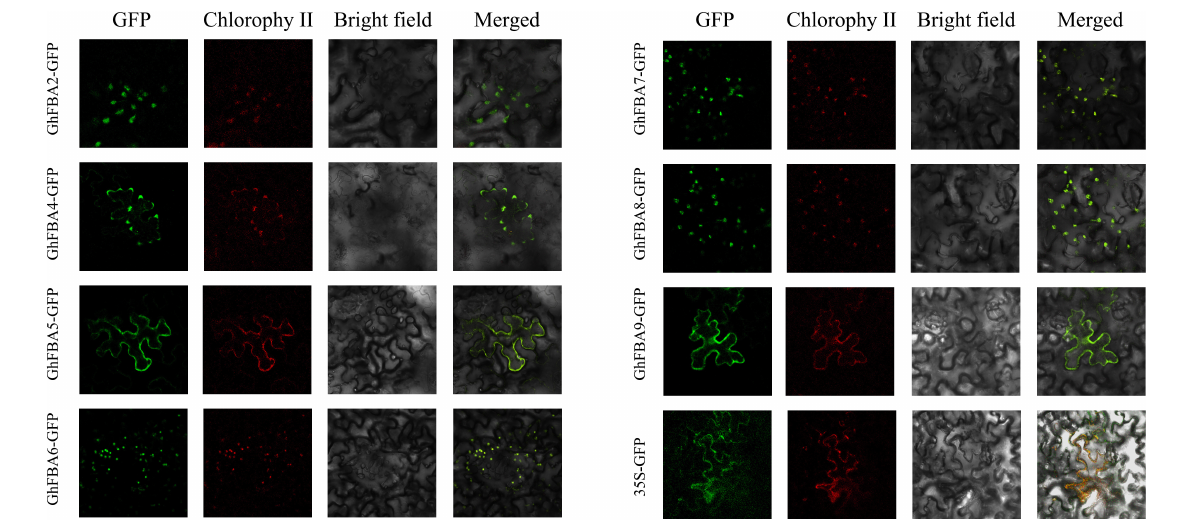
Frontiers in Plant Science |